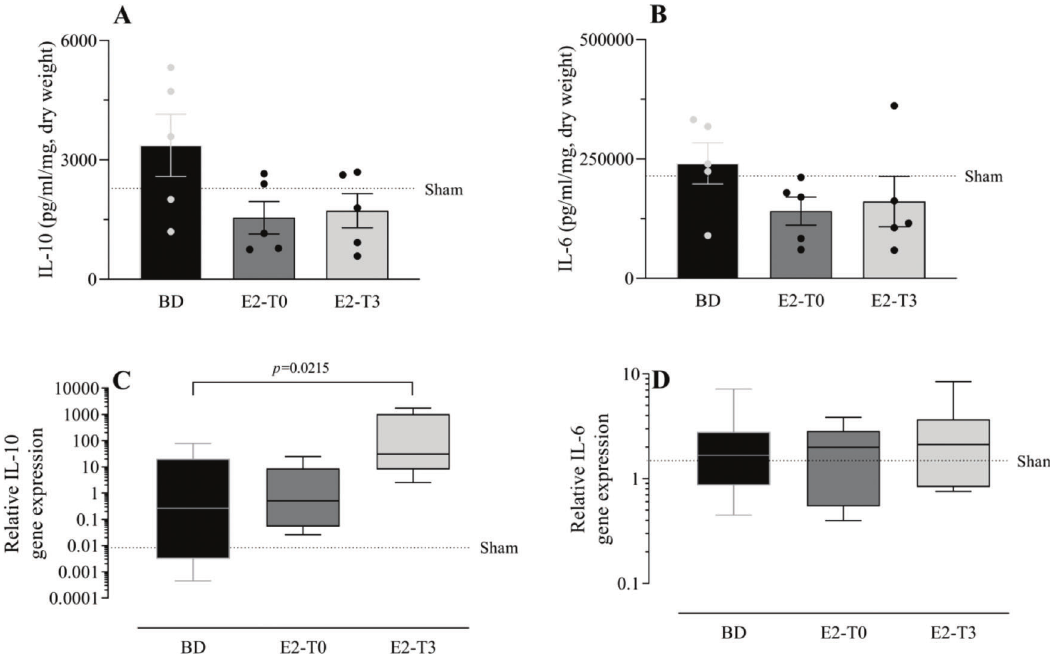
Figure 6 - L-10 and IL-6 concentration in lung culture medium (A, B) and lung gene expression (C, D). Female rats were separated in groups: sham animals as control, BD animals subjected to brain death (BD), E2-T0 animals subjected to BD and treated with 17 b -estradiol (E2) starting after BD confirmation, and E2-T3 animals subjected to BD and treated with E2 3h after BD confirmation. (A, B) Data are expressed as mean ± SEM from 5 animals. (C, D) Data expressed as median and 95% percentile interval from 5-6 animals (C) and 7 animals (D). Kruskal-Wallis p =0.1449 (A), p =0.2391 (B), p =0.0247 (C) and p =0.8071 (D).